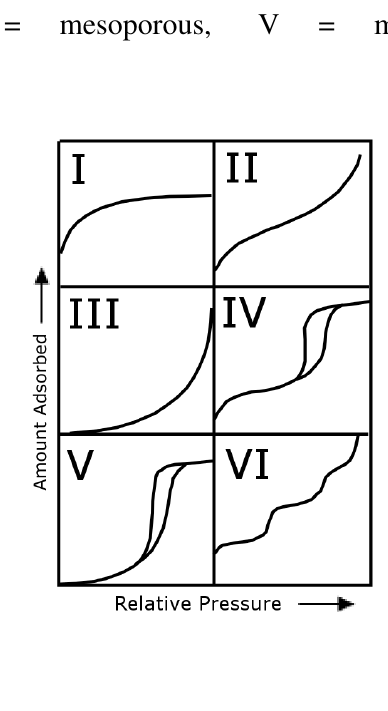
Figure 9. IUPAC classification of sorption isotherms. I = microporous, II = macroporous, III = non-porous or microporous, IV = mesoporous, V = microporous/mesoporous, VI =